Question: Identify the chart type used in this figure.
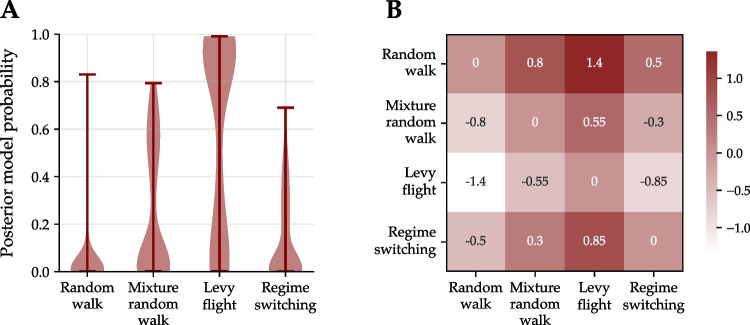
Answer: heatmap